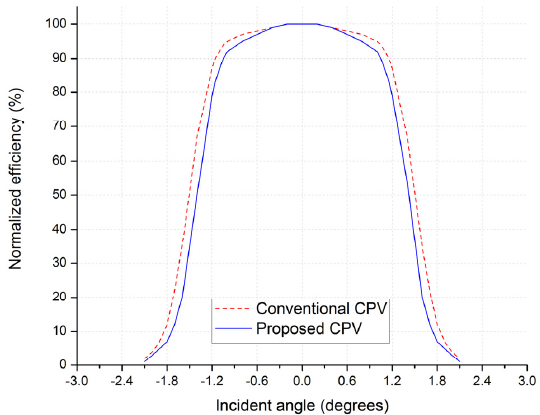
Figure 10. The angular transmission curve vs. incident angle for both conventional and proposed CPV units.